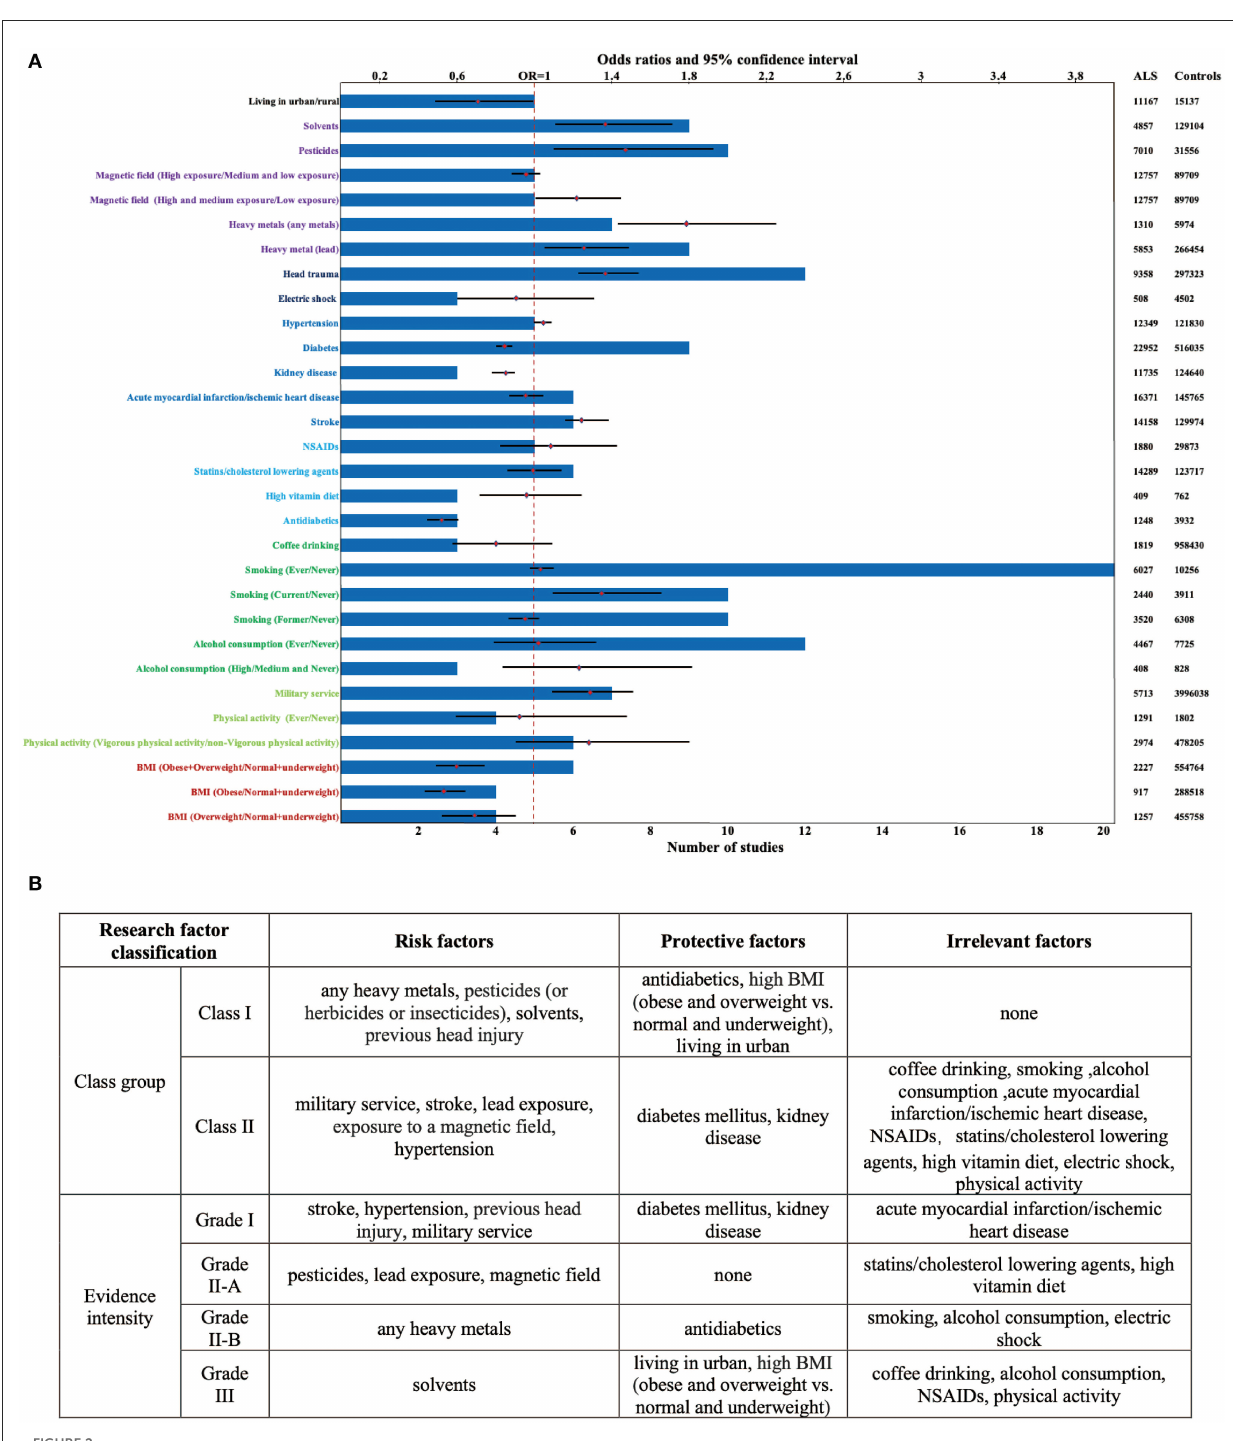
FIGURE2 Factors showing significant positive and negative associations with ALS. (A) A total of 13 factors showed a trend of increasing the risk of ALS while a total of 7 factors showed a trend of decreasing the risk of ALS. 21 factors were included in more than or equal to 5 studies, and 14 research factors had the sample size of over 5,000; (B) the class group and evidence intensity of the ALS protective/risk